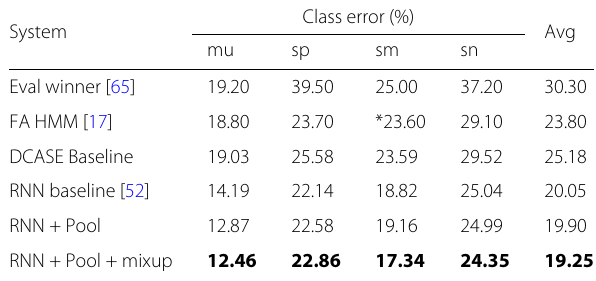
Table 10 Average class error and error per class obtained on the Albayzín 2010 test partition for different systems proposed in the literature compared to our proposed RNN approaches Class error (%) System Avg mu sp sm sn Eval winner [65] 19.20 FA HMM [17] DCASE Baseline 19.03 RNN + Pool 12.87 RNN + Pool + mixup 12.46